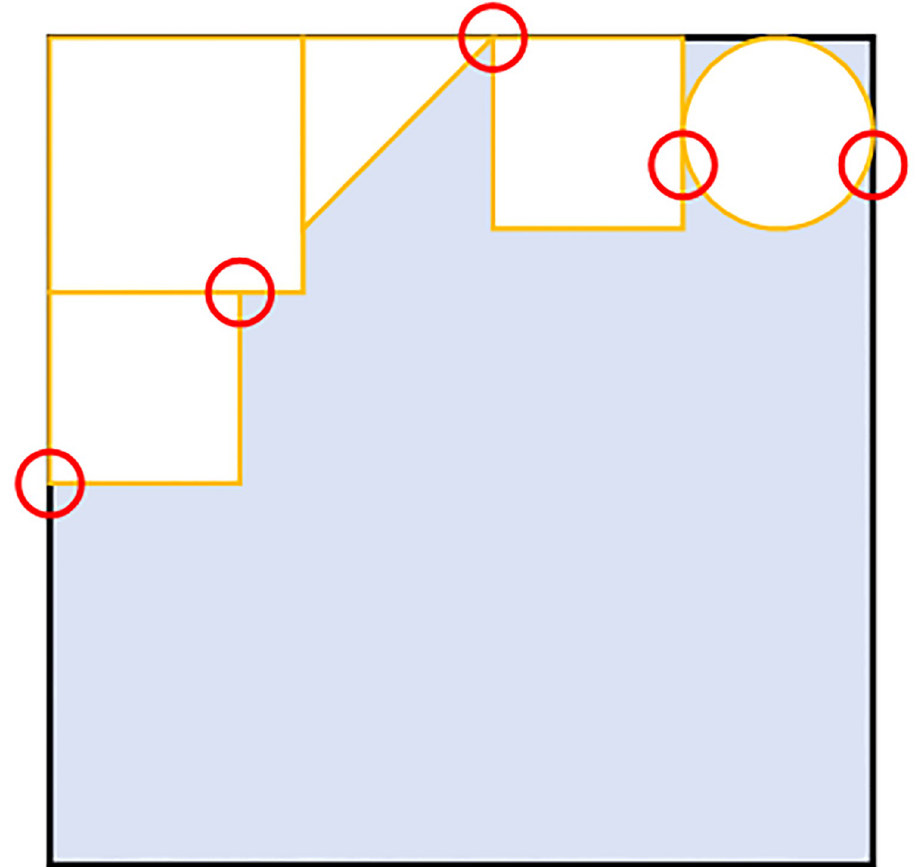
Fig 8. The corner positions. The positions circled in red are the corners in the bin. As the number of the parts in the bin increases, so does the number of corners.